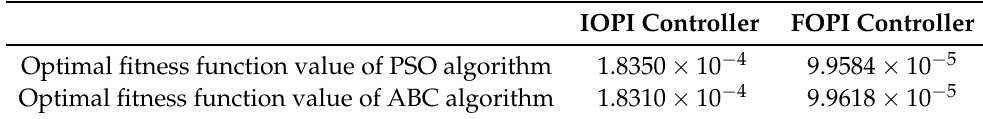
Table 3. Comparison of optimal fitness function Values between ABC algorithm and PSO